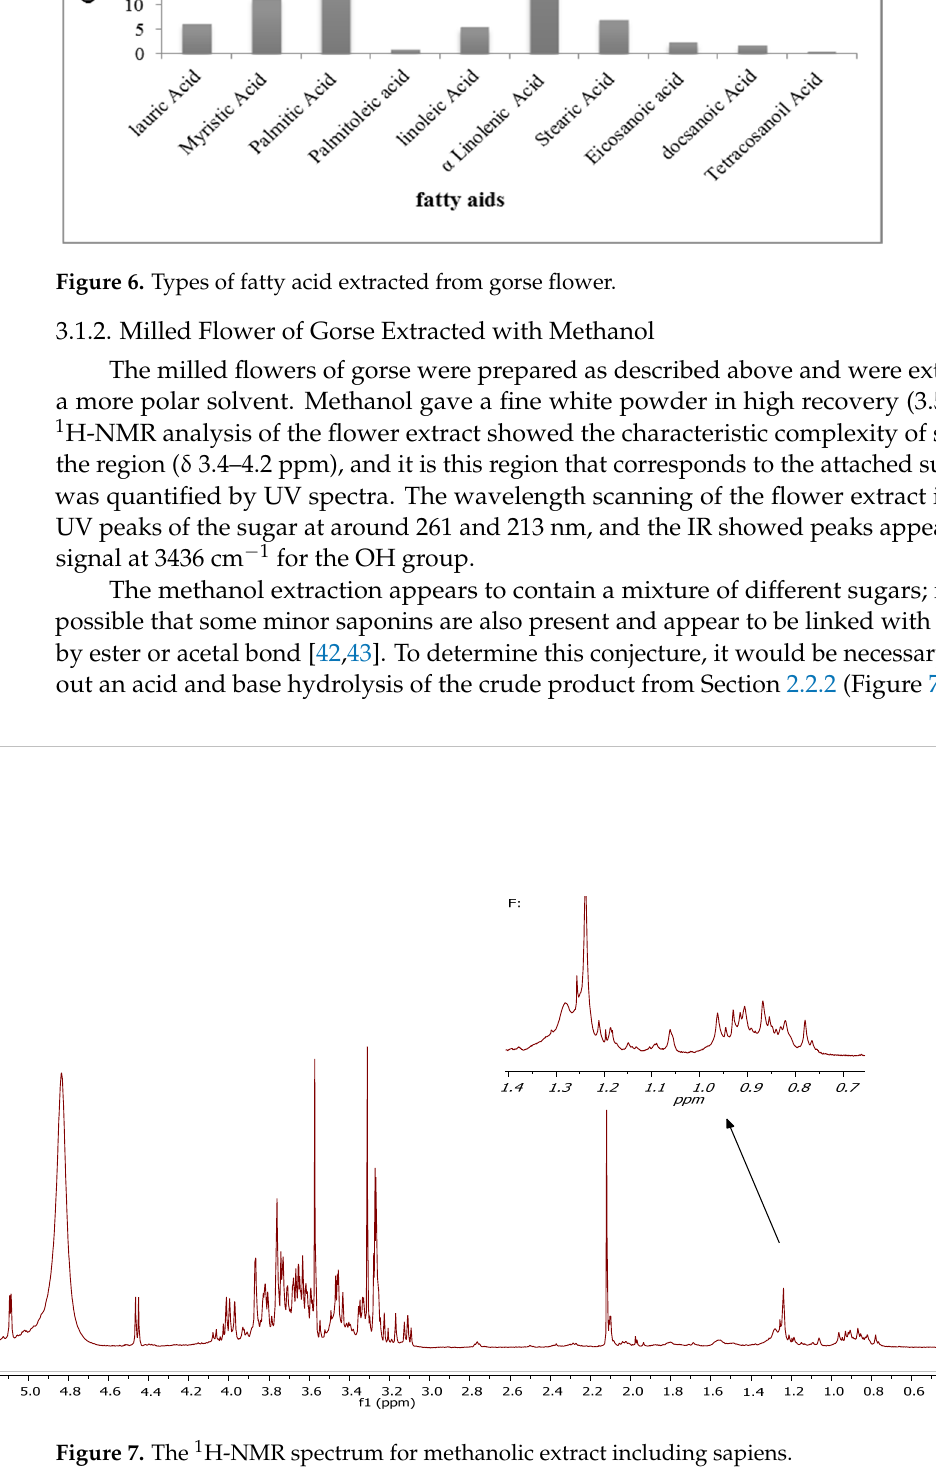
Figure 7. The 1 H-NMR spectrum for methanolic extract including sapiens.